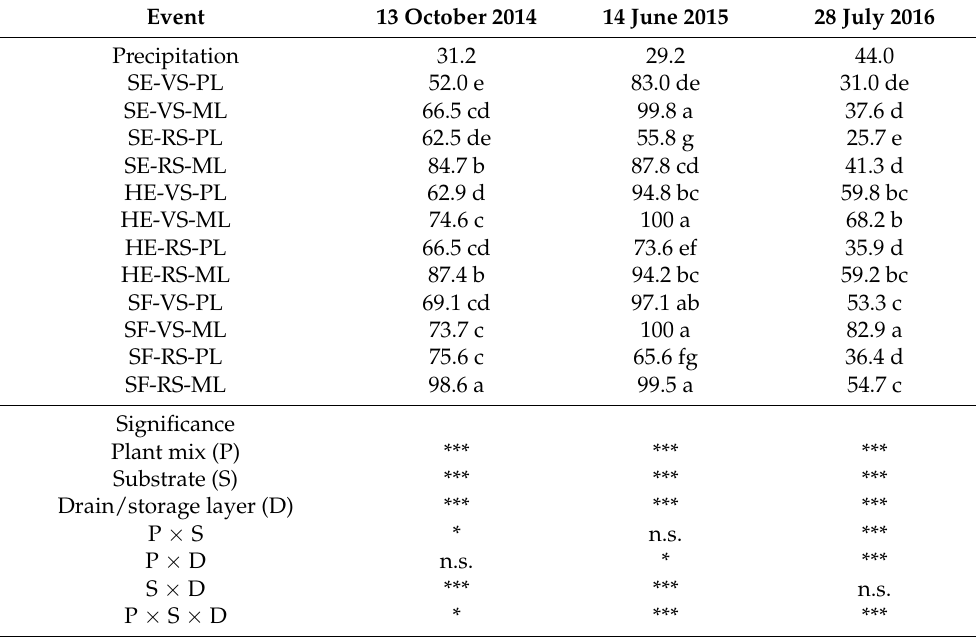
Figure 4. Rainfall outflows from the green roof microcosms in the two-year study in comparison with precipitation and the control (gravel). Histogram values with different letters indicate significant differences according to Tukey’s HSD test ( p < 0.05). SE = Sedum mix, HP = herbaceous perennial plants, SF = suffruticose, VS = volcanic substrate, RS = recycled crushed bricks substrate, PL = preformed plastic drainage/storage layer, and ML = mineral drainage/storage layer. Table 3. Average percentages of rainwater retained from each green roof microcosm type for the three heavy rainfall events with significant